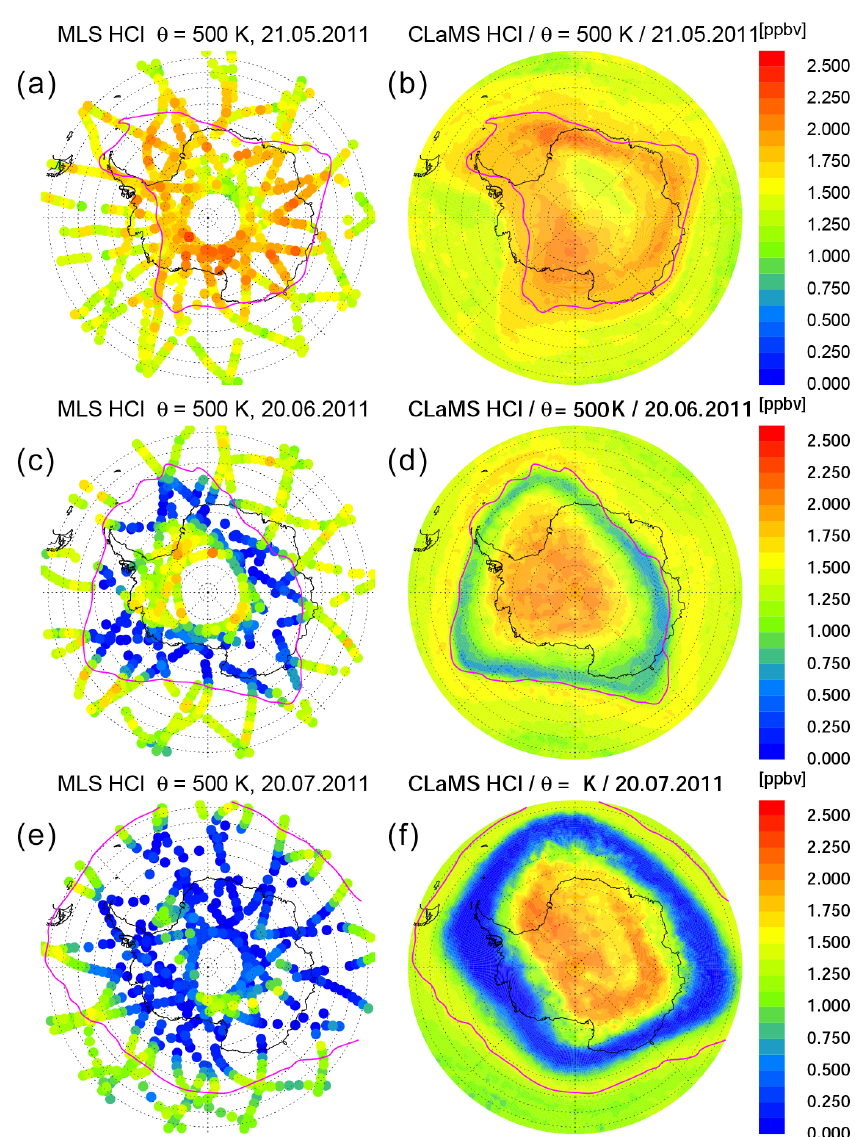
Figure 1. Time series of orthographic projection of MLS observations (a, c, e) and CLaMS simulations (b, d, f) of HCl mixing ratios on the 500K potential temperature level. The maps are shown for 21 May (a, b) , 20 June (c, d) and 20 July 2011 (e, f) . The pink line depicts the edge of the polar vortex according to the criterion of Nash et al.